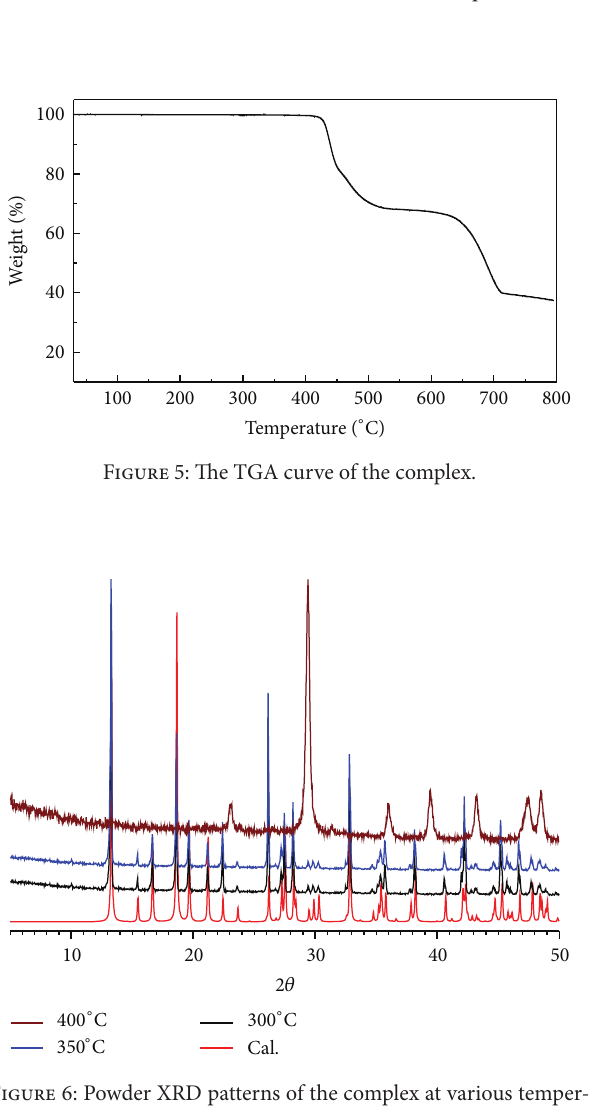
Figure 4: Powder XRD patterns of the complex (measured, (a); calculated, (b)).